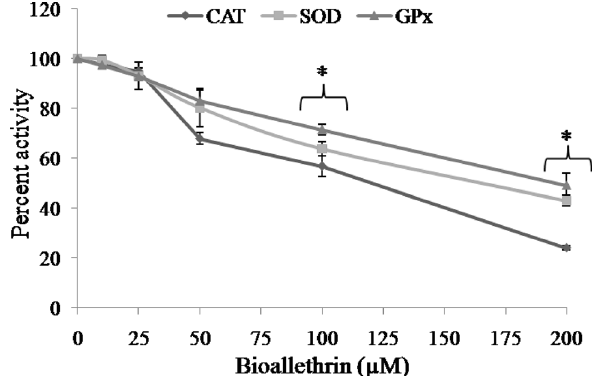
Figure 4. Effect of bioallethrin on the activities of antioxidant enzymes. All enzyme activities were determined in cell lysates. They are shown as percent activity with the activity of bioallethrin untreated (control) sample taken as 100 percent. Lymphocytes were incubated with bioallethrin for 2 h at 37 °C. Results are ± standard deviation of six different samples. *Significantly different from control at p < 0.05. SOD Cu,Zn superoxide dismutase; CAT catalase; GP glutathione peroxidase.